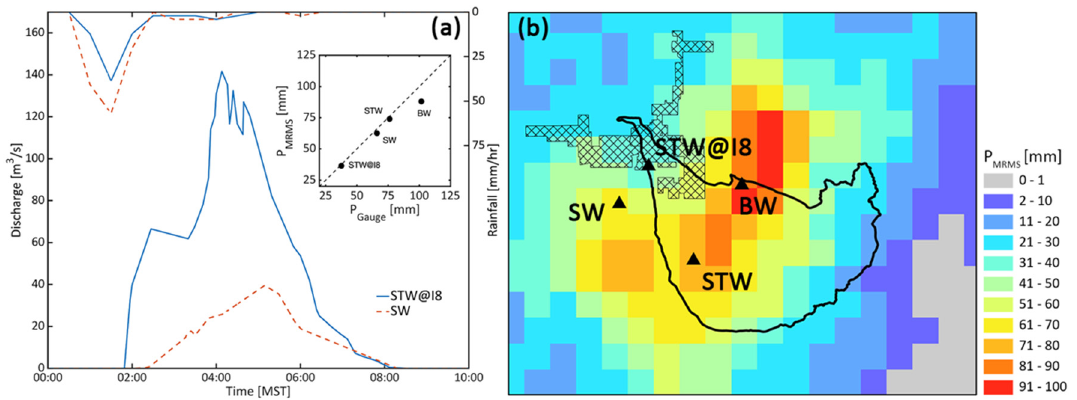
Figure 2. ( a ) Time series of rainfall (top axis) and streamflow (bottom axis) observations at STW@I8 (blue lines) and SW (red lines) stations, with the inset comparing the total precipitation during the storm between gauge records and the MRMS product. ( b ) Map of total precipitation from MRMS during the storm event, with the town of Gila Bend and Sand Tank Wash watershed shown for reference. The size of each MRMS pixel is 4 km.